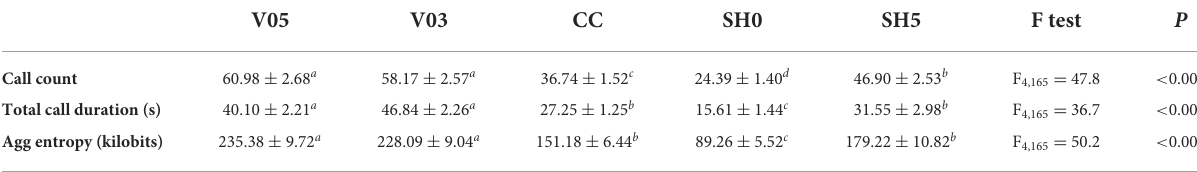
TABLE 6 Averages ( ± SE) of vocal parameters recorded during combined injection of local anesthetic and castration.